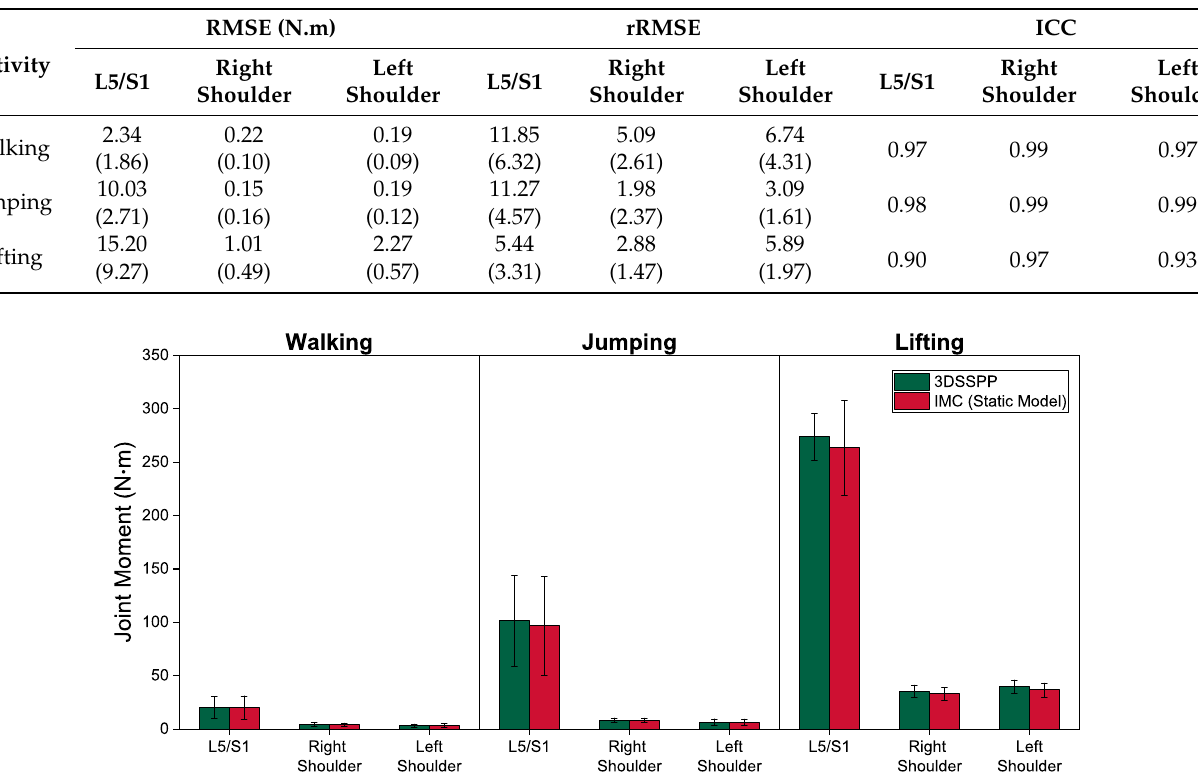
Table 2. The RMSE, rRMSE, and ICC values of the IMC model-predicted static net moments at the L5/S1, right, and left shoulder joints with respect to those calculated by 3DSSPP.